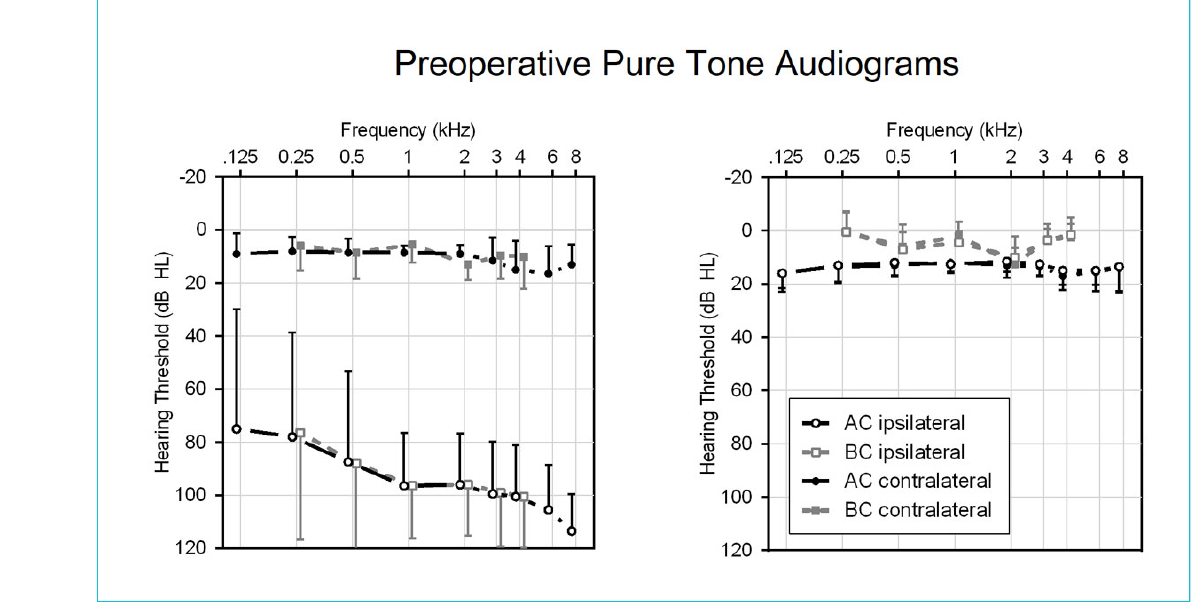
Figure 2: Averaged preoperative masked pure-tone thresholds of the patients (left panel) and normal hearing control participants (right panel). Data are shown as mean and standard